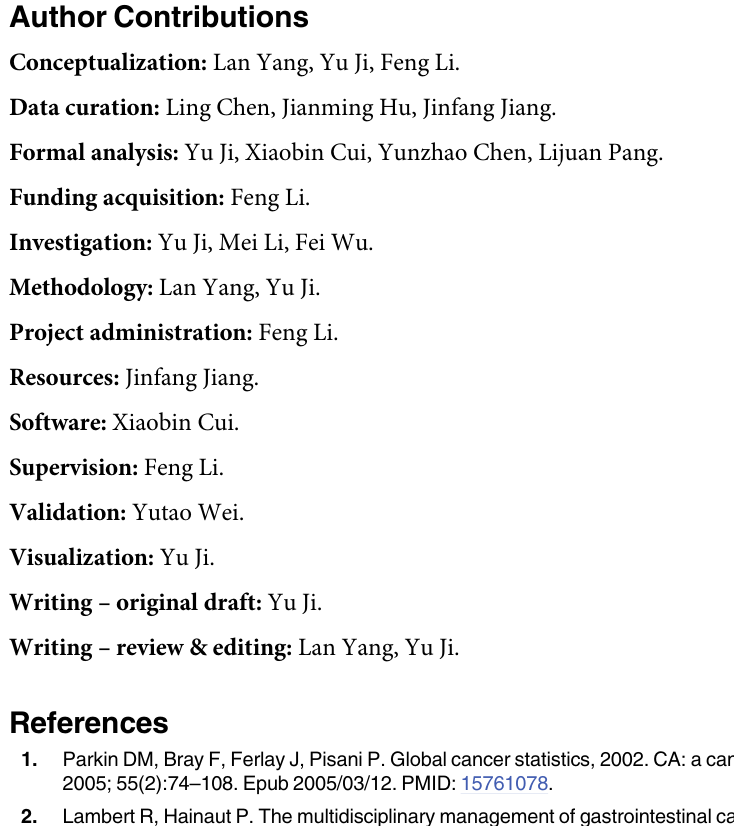
S1 Fig. LMP2 gene enzyme digestion and sequencing map. S2 Fig. LMP7 gene enzyme digestion and sequencing map. S3 Fig. Bioinformatics tools to analyze LMP2 gene expression. S1 Table. Primer sets used for amplification and sequencing of LMP/TAP genes. S2 Table. Hardy-Weinberg test for cases and controls. S3 Table. Epidemiological questionnaire in Chinese and in